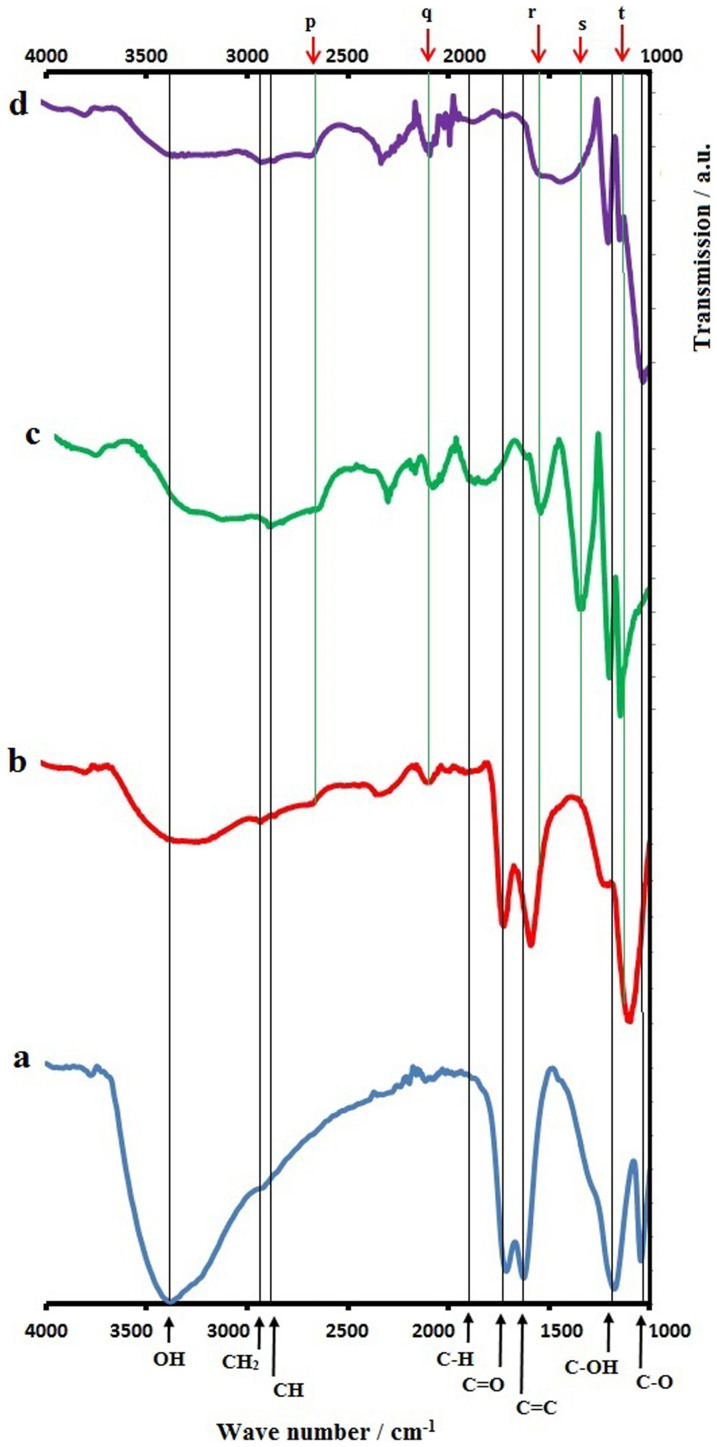
FTIR of (a) GO (b) GO-MnO2 before discharge, dried (c) GO-MnO2 after discharge, not dried (d) ERGO-MnO2.